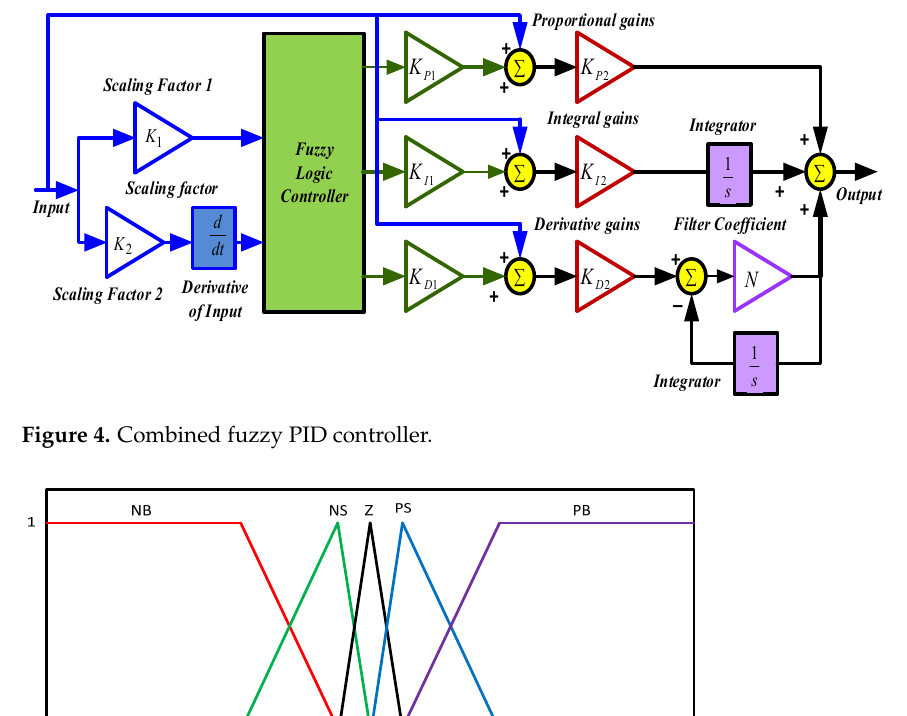
Figure 4. Combined fuzzy PID controller.